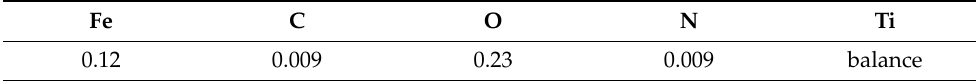
Table 1. Chemical composition of the Grade 2 titanium sheet (in wt.%). Fe C O N Ti 0.12 0.009 0.23 0.009